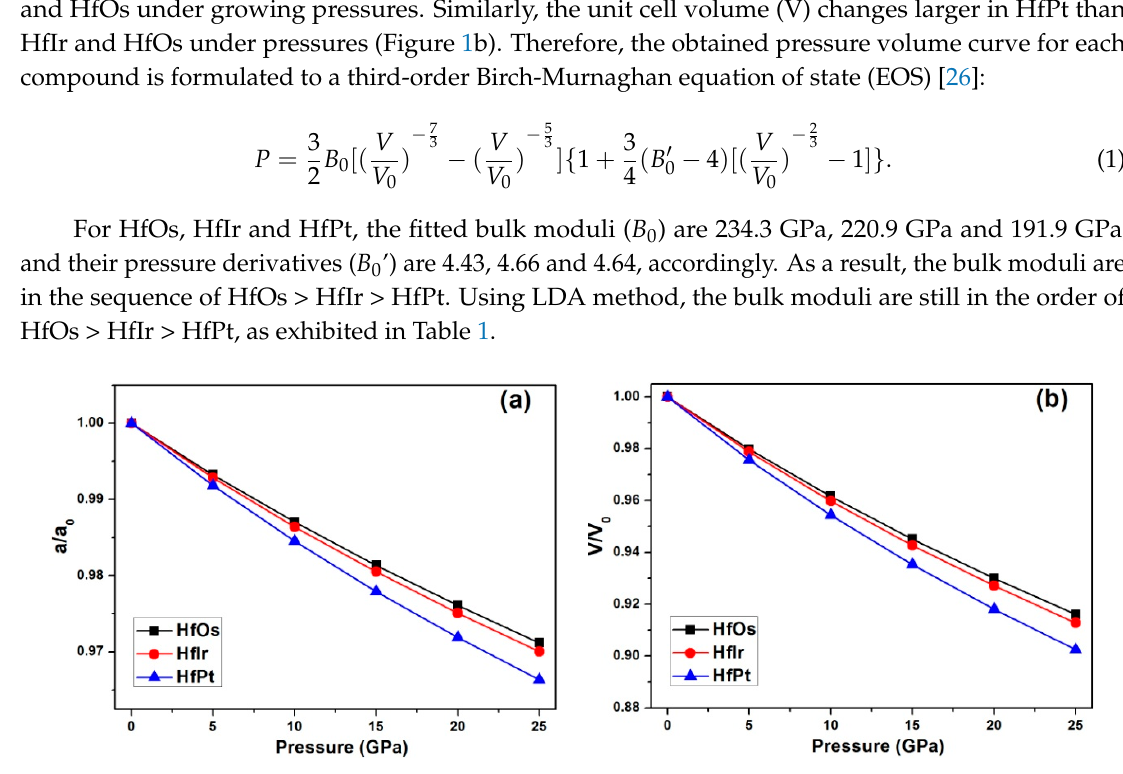
Figure 1. The relative changes of ( a ) lattice constant ( a ); ( b ) unit cell volume ( V ) with the elevating pressures computed by GGA method for HfX (X = Os, Ir and Pt).